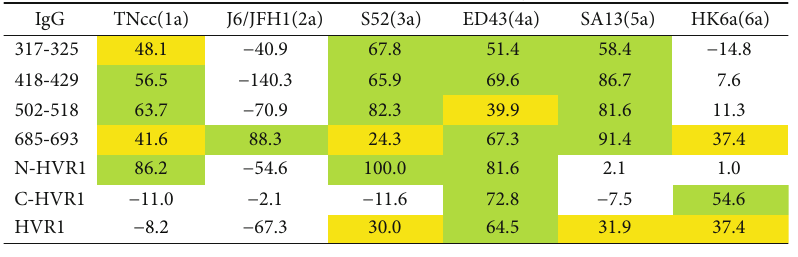
Figure 3: Neutralization activity of antiserum IgG. (a) IgG (100 μ g/mL) induced by each peptide was mixed with 400 FFU of HCVcc for 1h and added to Huh7.5 cells preseeded in a 24-well plate. Seventy-two hours later, infectivity was evaluated by Western blotting. nmIgG: normal mouse IgG. (b) The density of each band was analyzed with ImageJ software, and the core/Tublin ratio was calculated. The infection of nmIgG was set to 100%, and the relative infection of each group was calculated with GraphPad Prism 8 software. (c) Neutralization breadth of mouse IgG (100 μ g/mL). Green, neutralization is > 50%; yellow, neutralization is